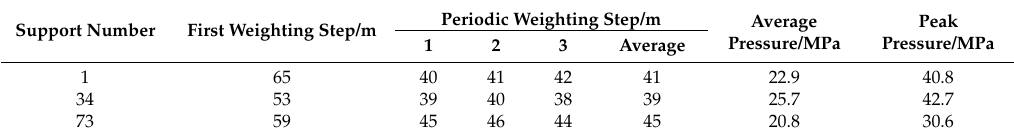
Table 2. Hydraulic support resistance statistic.